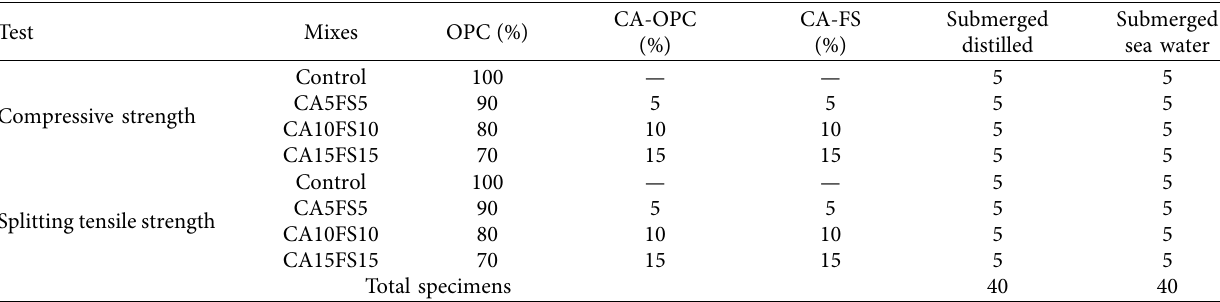
Figure 4: Sample preparation: (a) sample after 24 hours casting, (b) sample in distilled water immersion, and (c) sample in sea water immersion. Table 3: The design of specimens for the experiment.